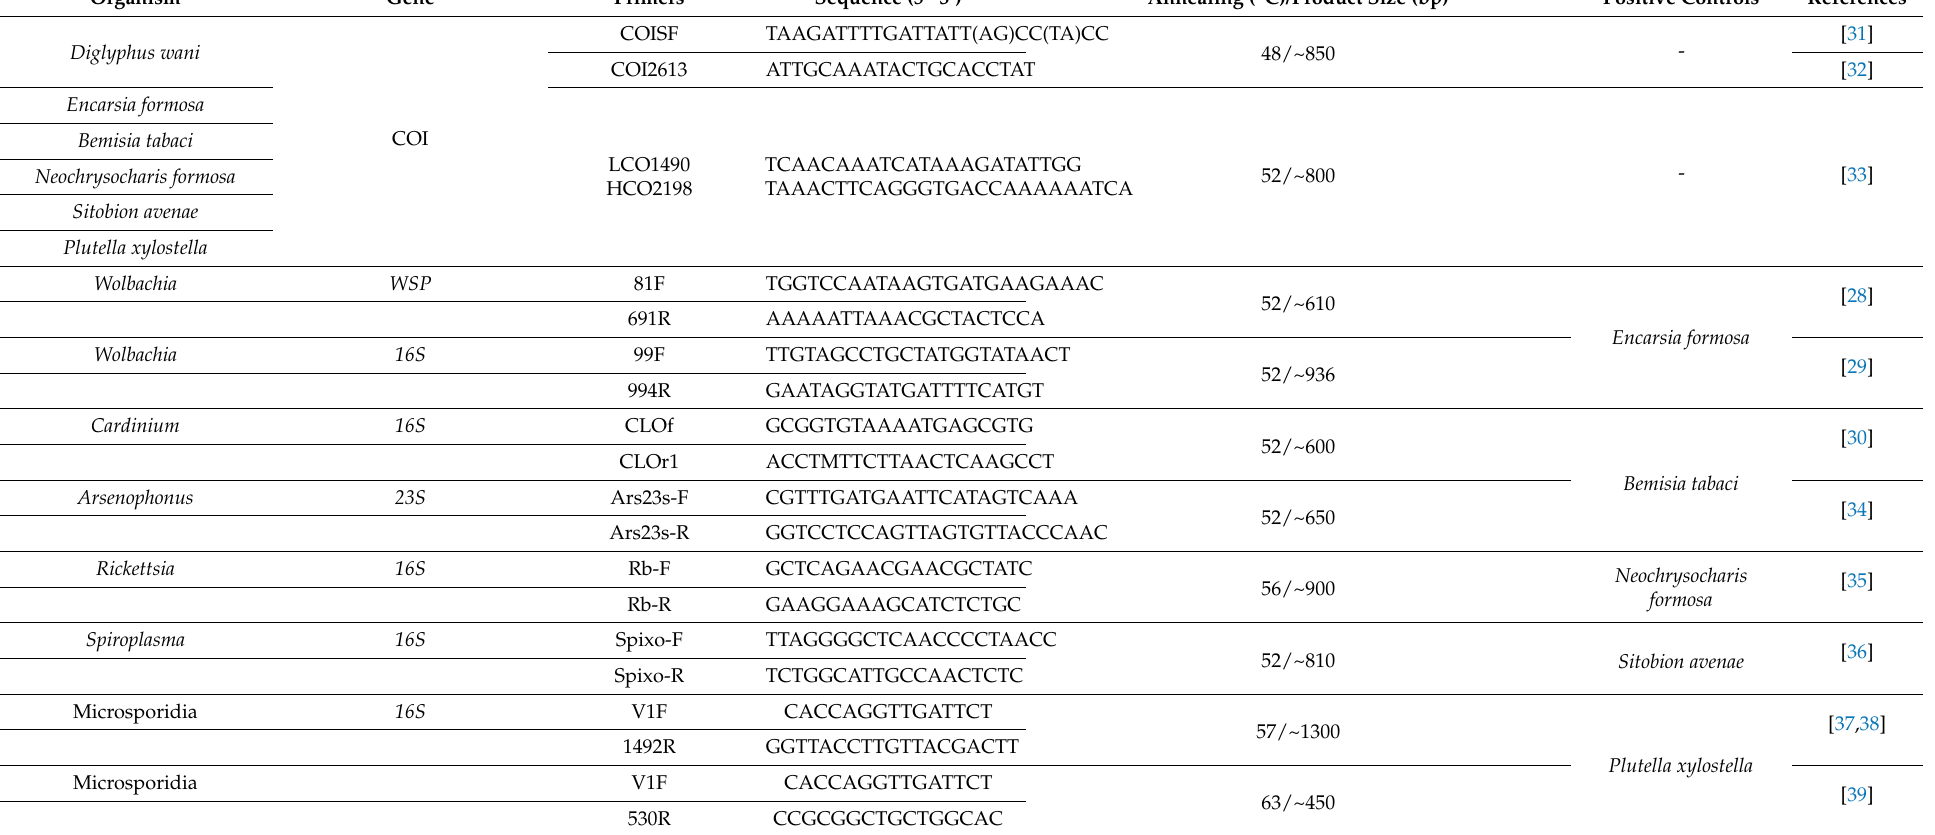
Table 2. Primers used in general polymerase chain reaction (PCR) assays to detect microbes manipulating